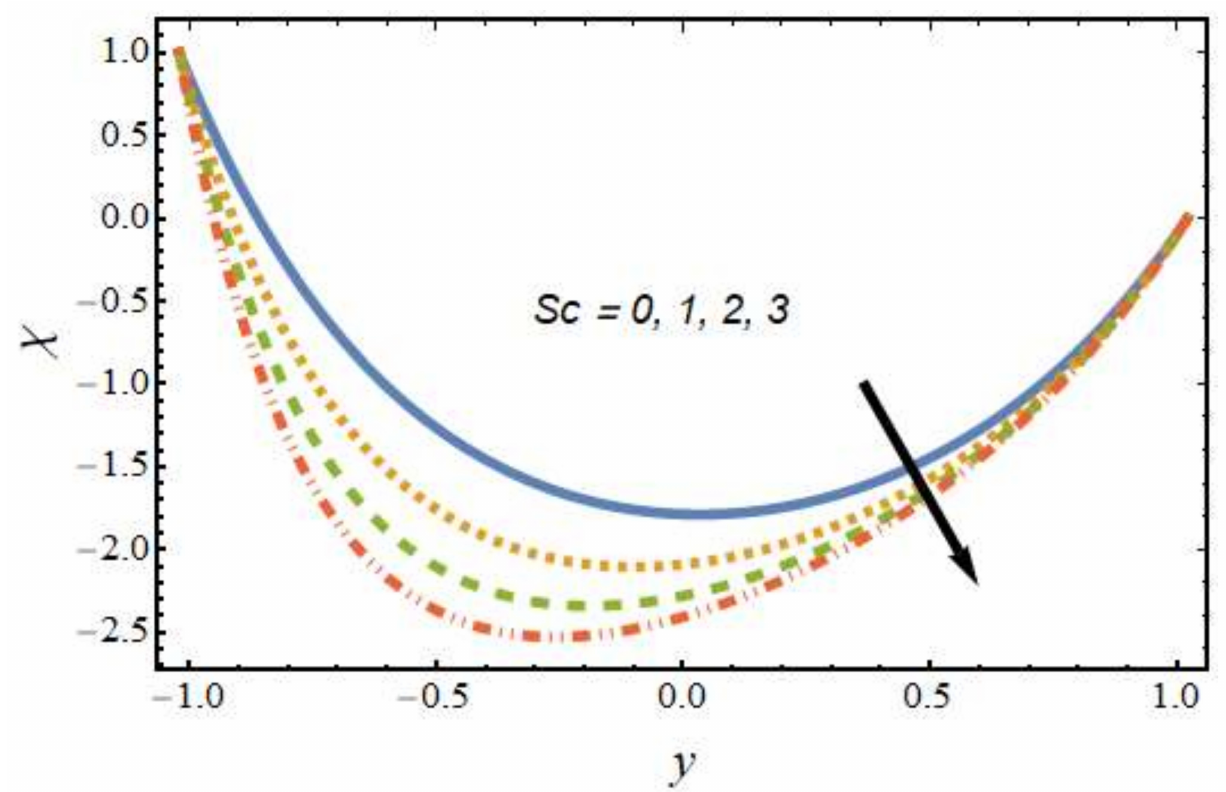
Figure 19. Motile microorganism profile for various values of the Schmidt